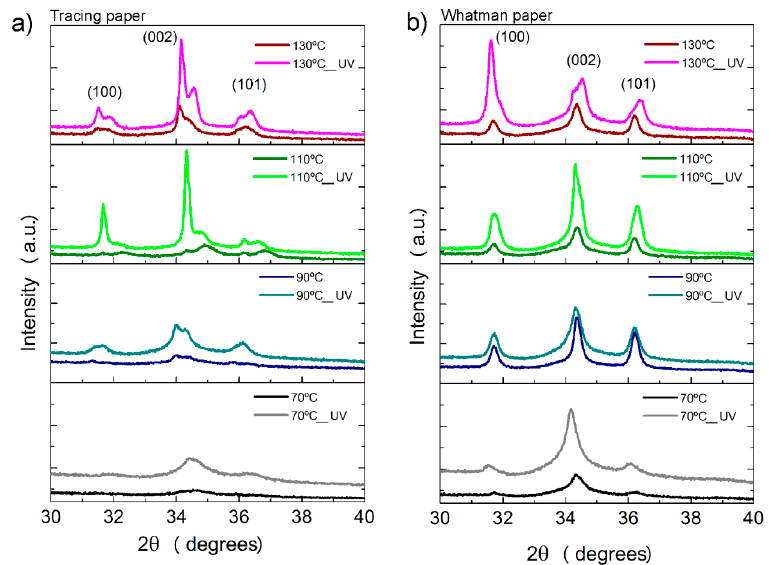
Figure 5. XRD diffractograms of ZnO nanorods arrays produced by an ultrafast hydrothermal method assisted by microwave irradiation, grown on ( a ) tracing paper substrate and ( b ) Whatman paper substrate. All samples were produced with a synthesis time of 10 min.